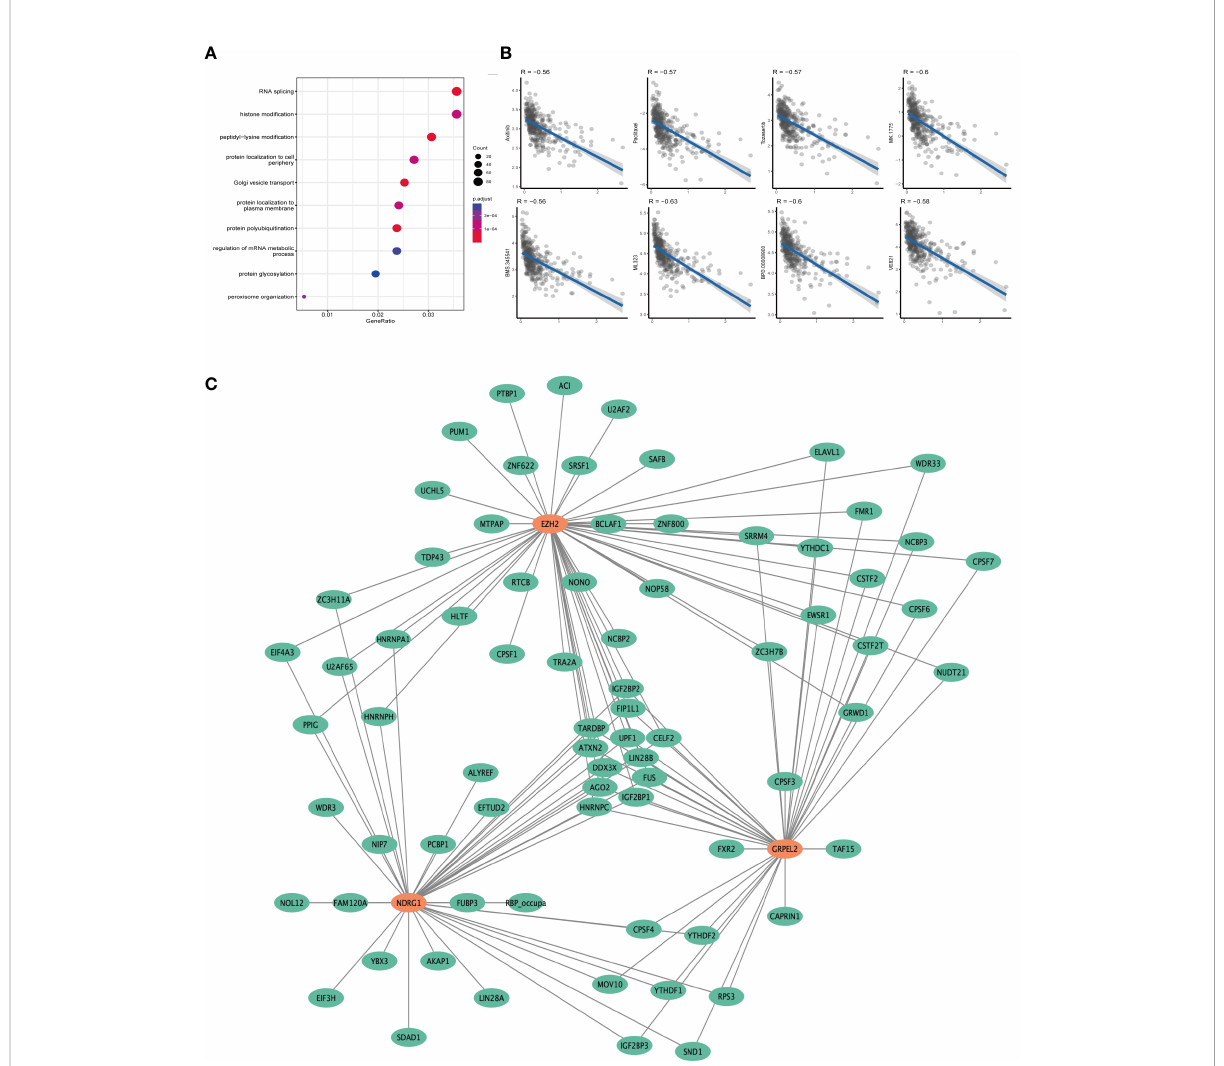
FIGURE 8 Prognostic model related related functional analysis. (A) Functional enrichment analysis results of NDRG1 knockout dataset. The bluer the color in the fi gure, the more meaningful the result. (B) The relationship between prognostic model and drug sensitivity. Each point in the graph represents the model score of a sample as well as the drug sensitivity score. (C) Post-transcriptional regulatory network of genes associated with prognostic models. The orange circle represents the gene in the model, and the green circle represents the poor post-transcriptional regulatory